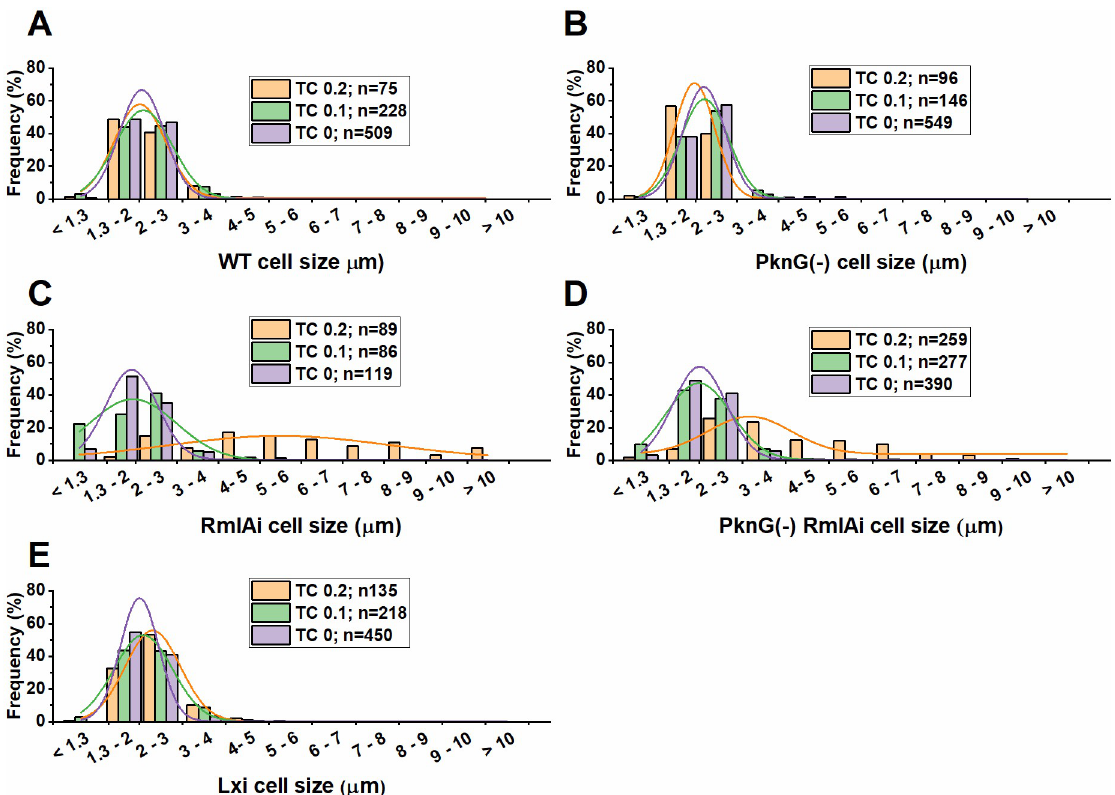
Fig 5. Cell elongation upon RmlA overexpression. The normalized distribution of cell length is shown as bars. Gaussian curve fitting to the data is shown as smooth lines. The number of cells counted in each sample (n) is shown in the legend. RmlA overexpression was induced by 0.1 or 0.2 μ g/ml TC (TC 0.1 and TC 0.2 respectively). TC 0 stands for non-induced controls. The highest probability cell length yielded by the Gaussian curves in each case is the following in the order of 0.2 μ g/ml TC; 0.1 μ g/ml TC and no TC: 2.02 ± 0.03 μ m; 2.10 ± 0.02 μ m; 2.06 ± 0.08 μ m for the WT; 1.98 ± 0.01 μ m; 2.22 ± 0.01 μ m; 2.20 ± 0.01 μ m for the PknG(-); 5.48 ± 0.53 μ m; 1.94 ± 0.16 μ m; 1.91 ± 0.02 μ m for the RmlAi; 3.17 ± 0.20 μ m; 1.99 ± 0.01 μ m; 2.01 ± 0.02 μ m for the PknG(-); RmlAi and 2.32 ± 0.01 μ m; 2.10 ± 0.02 μ m; 2.01 ± 0.02 μ m for the Lxi